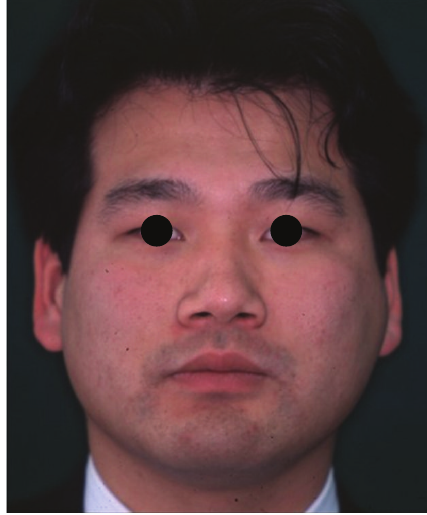
Figure 6: Frontal view of the patient one year after reconstructive